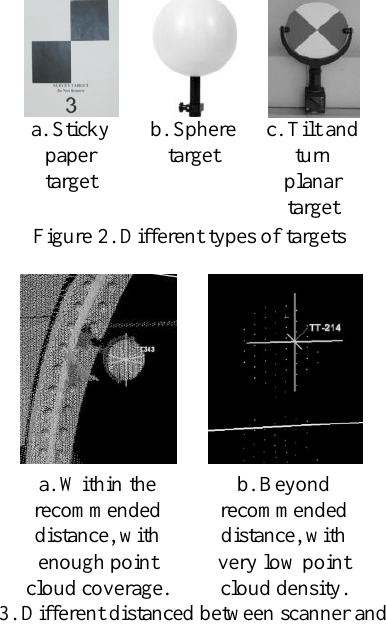
Figure 3. Different distanced between scanner and target Capture of point cloud